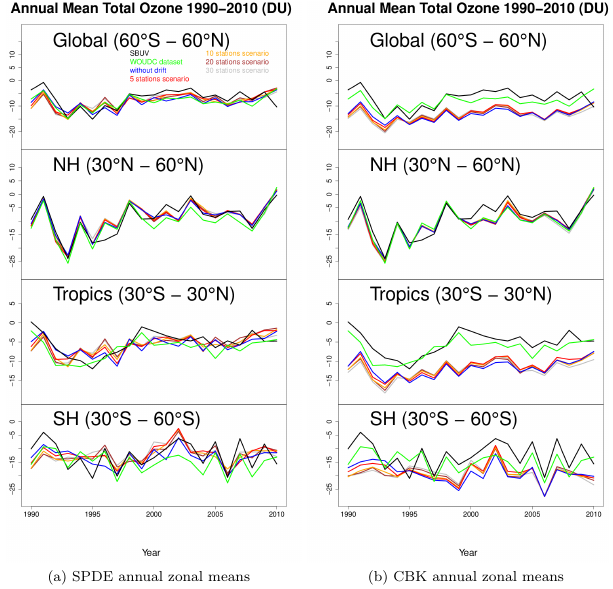
Figure 14. Annual zonal mean deviances from SBUV data (black), WOUDC data set (green), using all 57 available ground-based data (blue), adding drift to 5 (red), 10 (yellow), 20 (brown) and 30 (grey) stations in SPDE and covariance-based kriging (CBK) estimation over the (1) global (60 ◦ N–60 ◦ S), (2) NH (30–60 ◦ N), (3) tropics (30 ◦ N–30 ◦ S) and (4) SH (30–60 ◦ S) from 1990 to